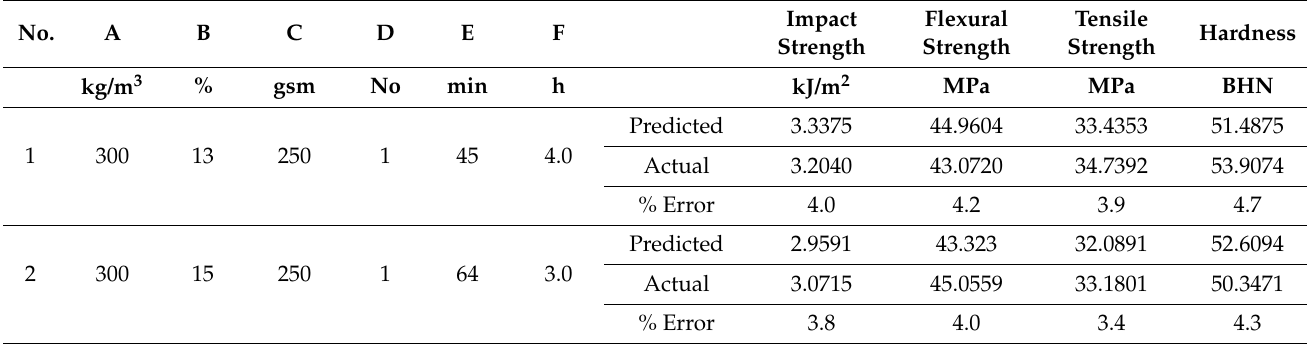
Table 10. Confirmatory test results with % error (maximised conditions).